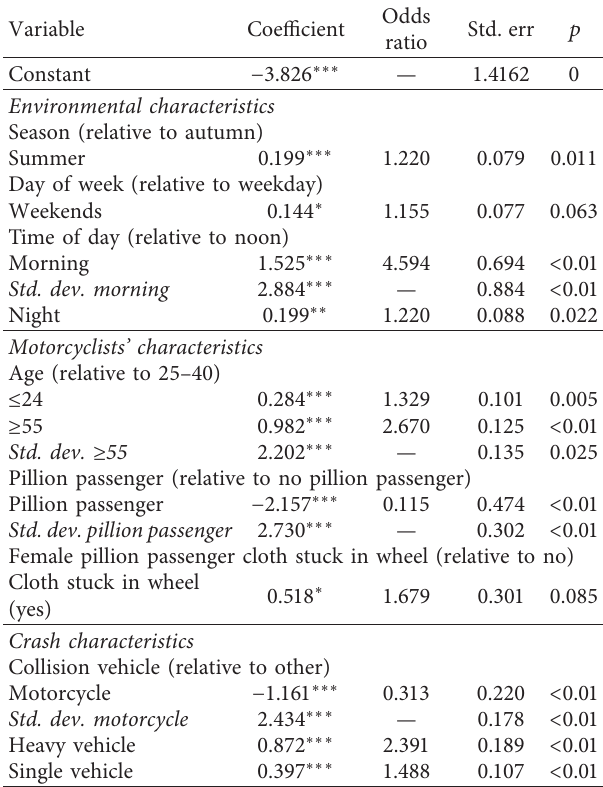
Table 3: Estimation results for the random parameter